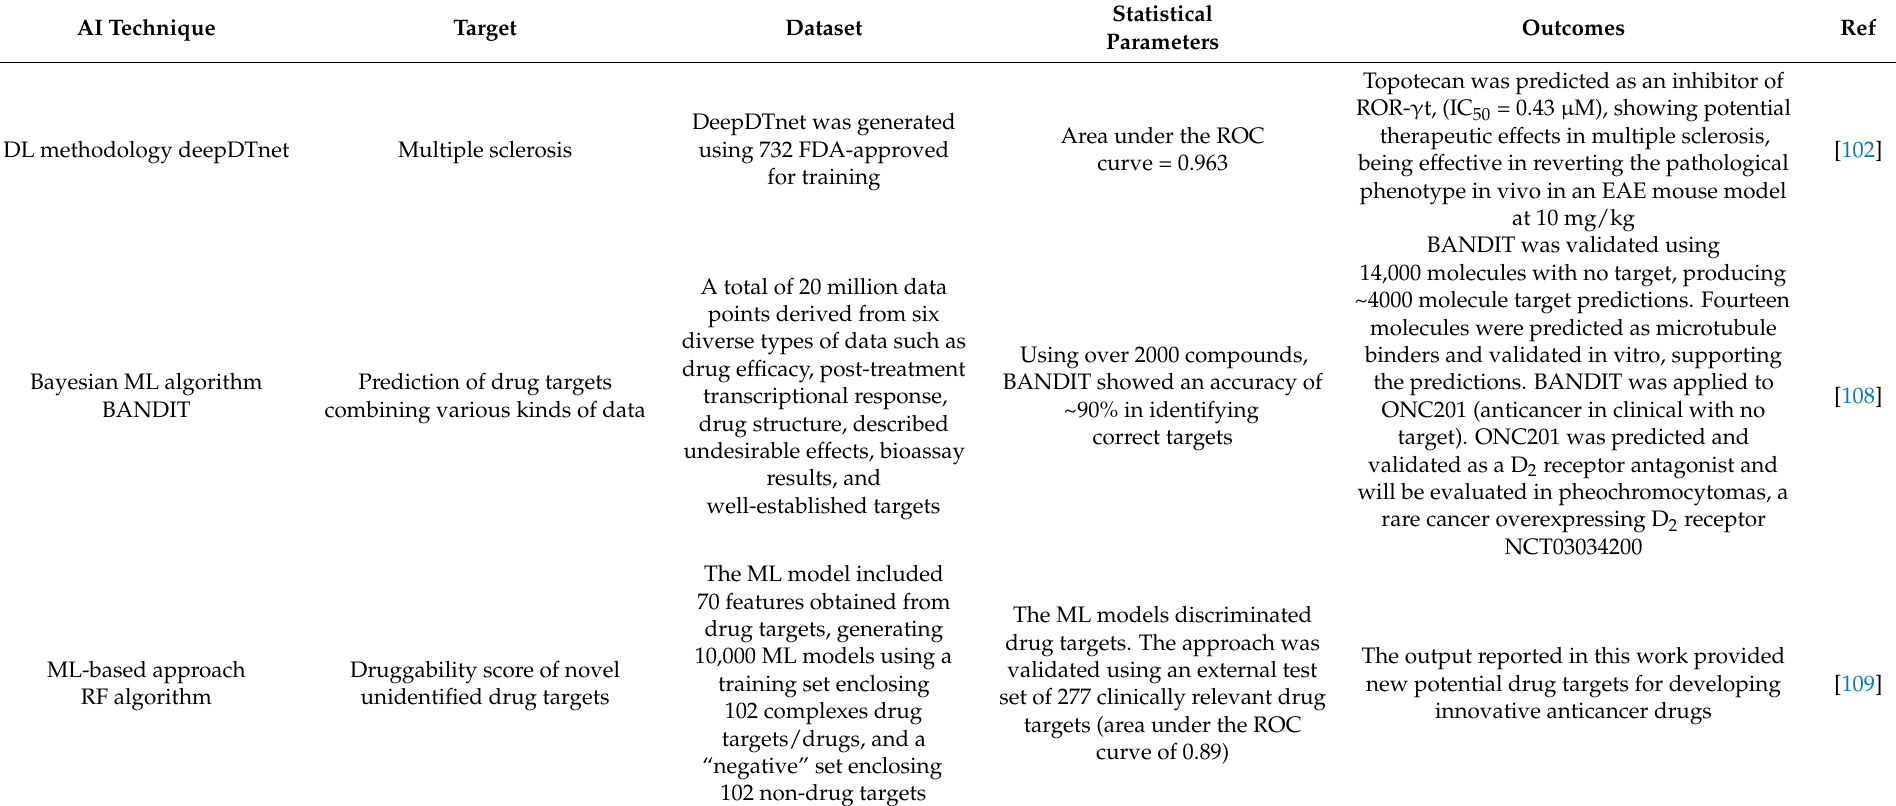
Table 2. Main examples of AI/ML in drug target prediction and biomarker